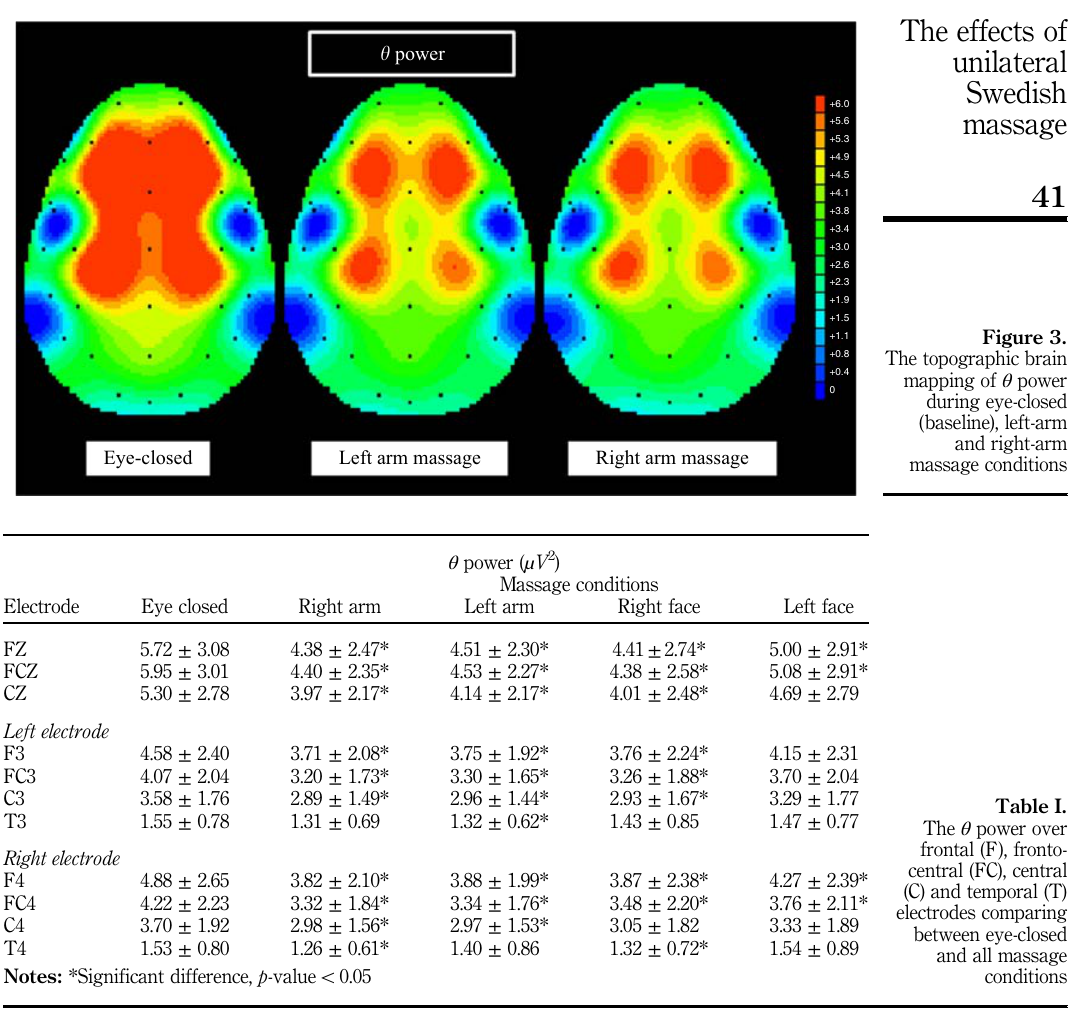
Table I. The θ power over frontal (F), fronto- central (FC), central (C) and temporal (T) electrodes comparing between eye-closed and all massage